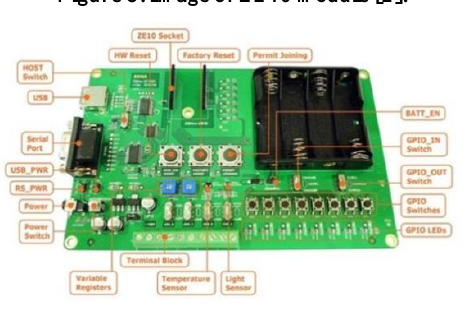
Figure 5. Image of ZE10 module [2].